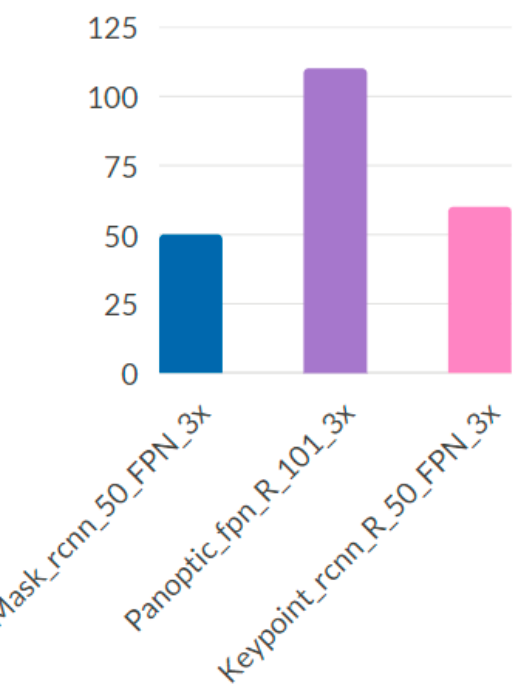
Figure 10. Results of the second experiment weight file for the false-positive tests.